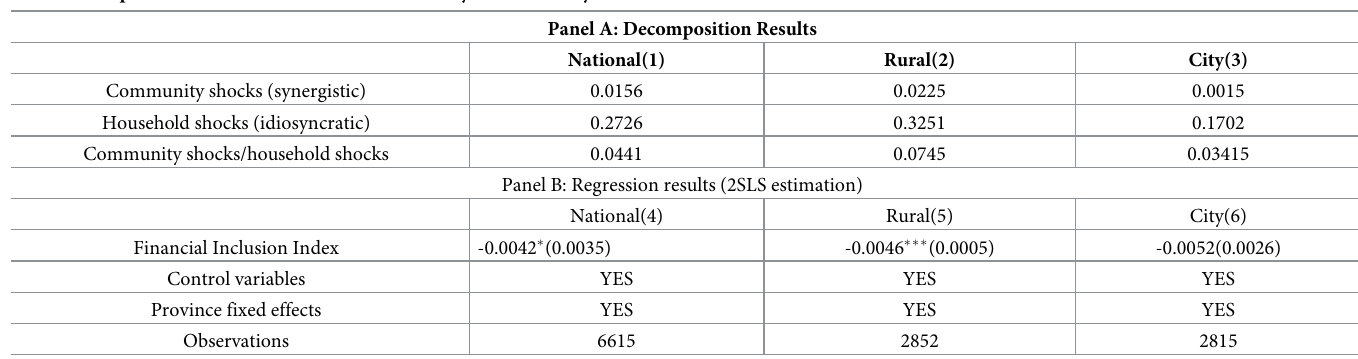
Table 10. Impact of financial inclusion on vulnerability to community